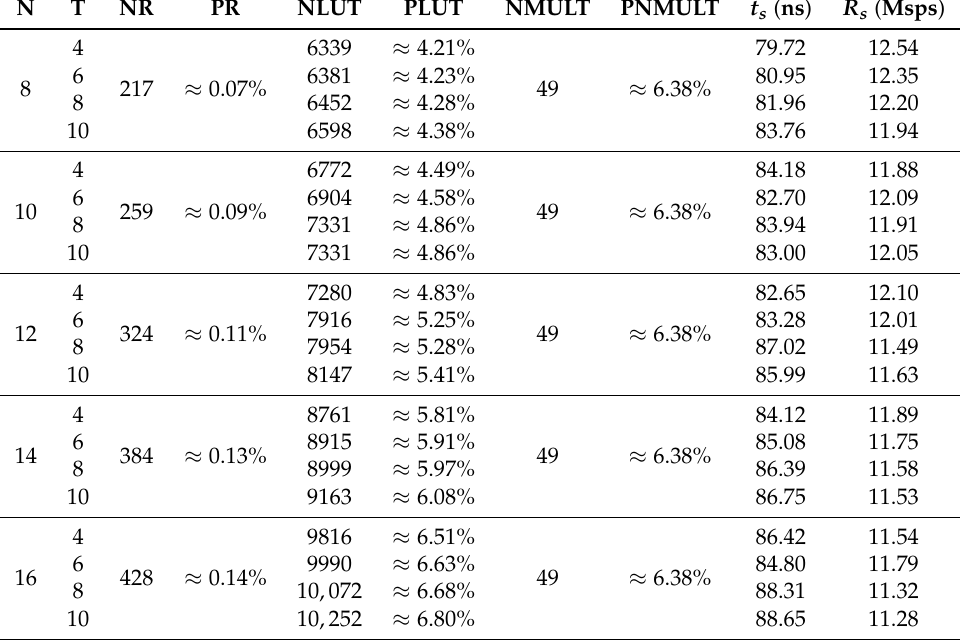
Table 1. Synthesis results (hardware requirement and time) associated with TS-FIMM-OS